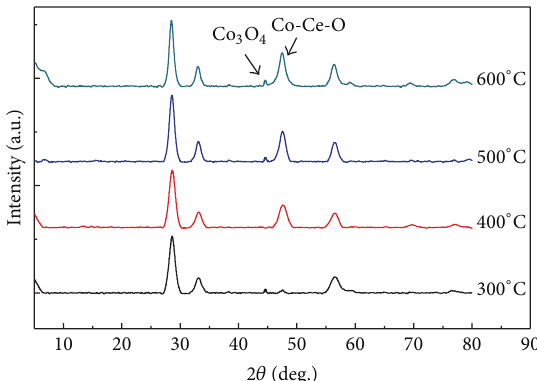
Figure 8: XRD pattern of Co 3 O 4 /CeO 2 photocatalysts under different calcination